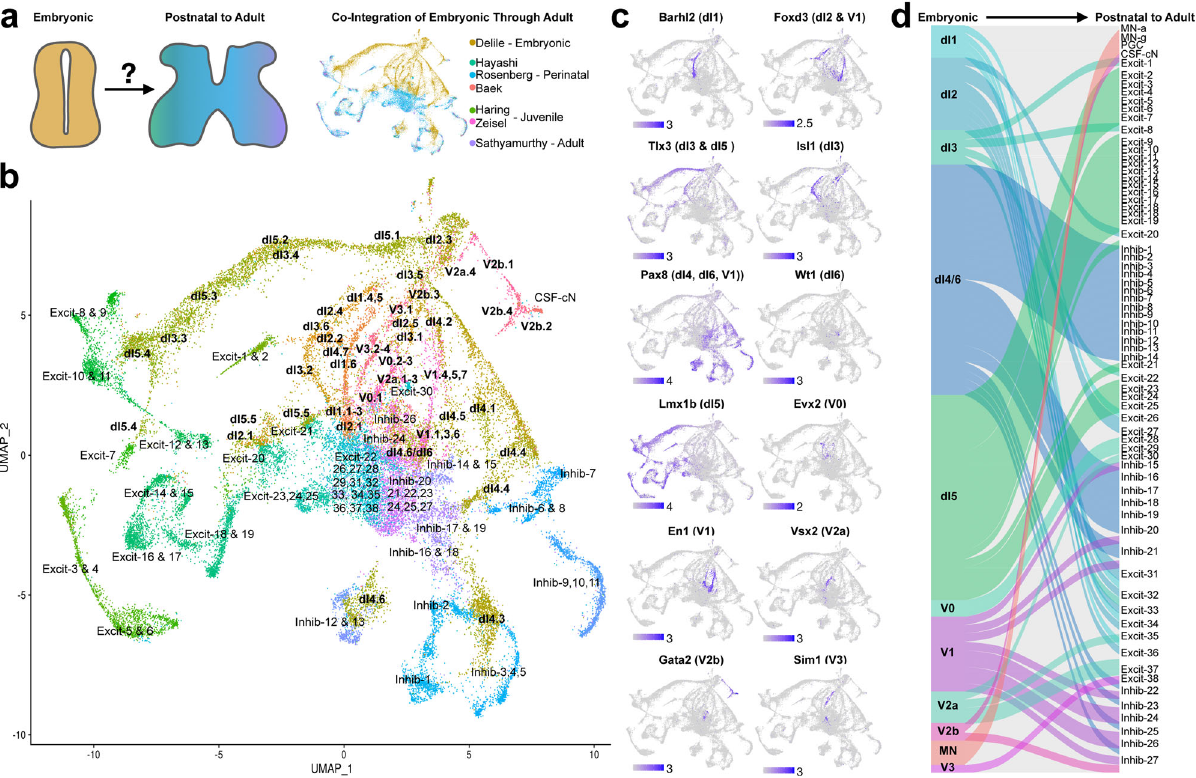
Fig. 5 Co-integration of embryonic and postnatal through adult spinal cord neuronal types. a To reveal the temporal relationship between embryonic and postnatal through adult cell types, the Delile, and harmonized datasets were co-integrated and are shown in a UMAP, colored by dataset (right). b A UMAP of the co-integrated datasets, colored by clusters from the Delile et al. study (bold labels) or the harmonized analysis (regular font labels). Cluster annotations are repeated in cases in which a group of cells from a given cluster are located at a distance from the cluster centroid (ex. for dI4.6). c Feature plots of selected marker genes for the cardinal classes of spinal cord lineages. d Sankey plot of the relationships between embryonic lineages (left) and harmonized cell types (right) showing multiple examples of divergence and